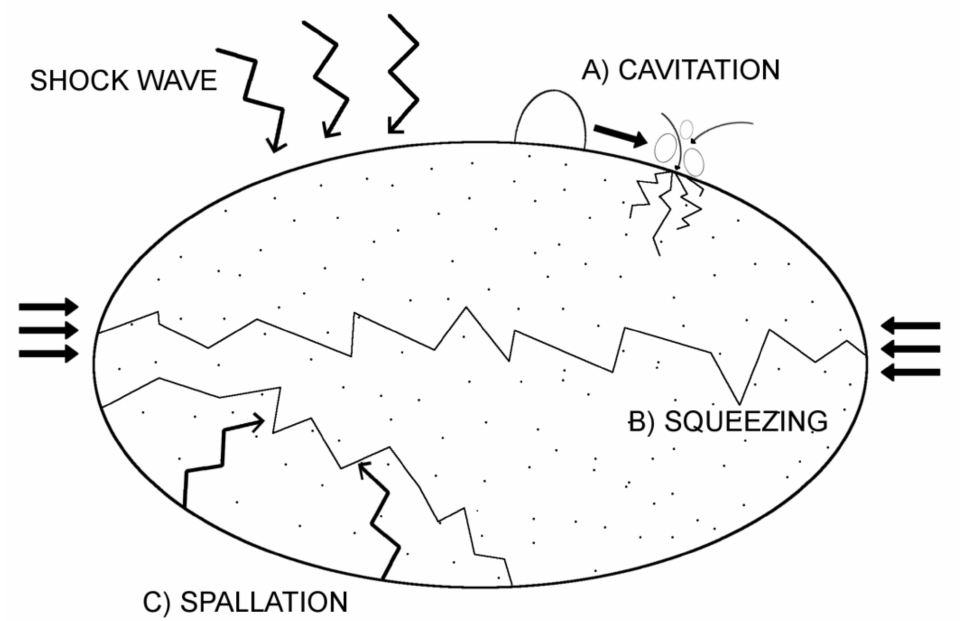
Figure 1. Mechanism of Shock Wave action-related stone